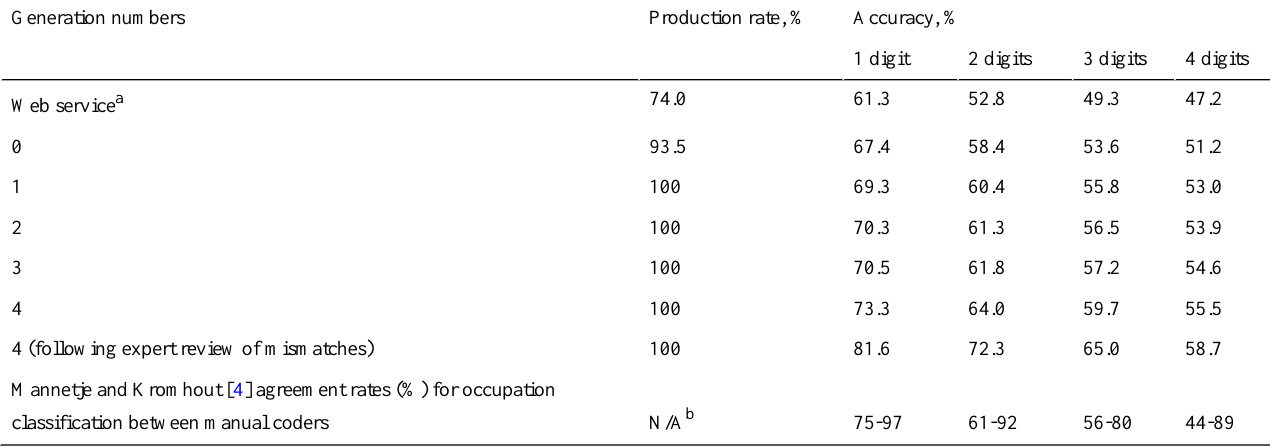
Table 3. Production rate and accuracy of occupation coding (NOC 2016) with the ACA-NOC algorithm by generation number (N=566).